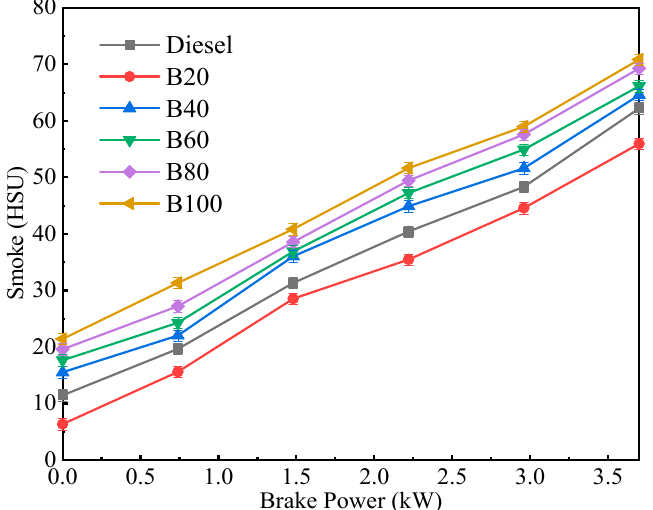
Figure 35. Smoke emission comparison of castor biodiesel blends and diesel under different brake powers [185].